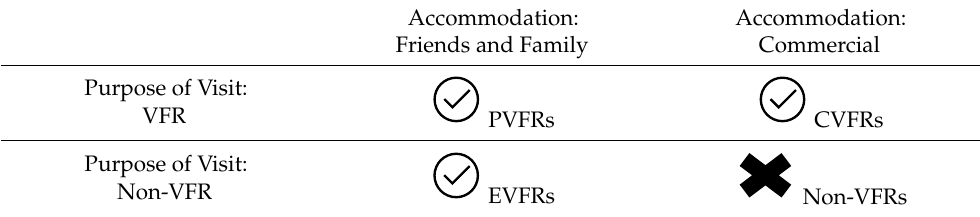
Table 1. VFR types.